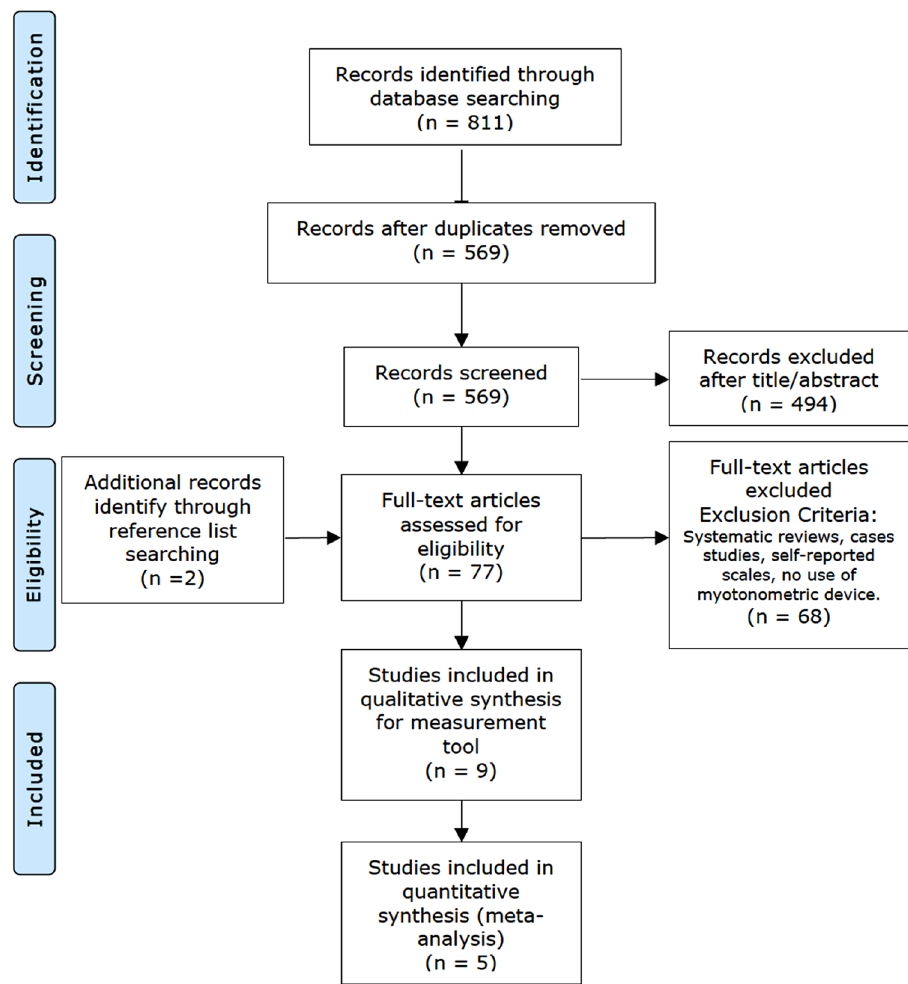
Figure 1. Flow diagram of trial selection based on PRISMA guidelines.